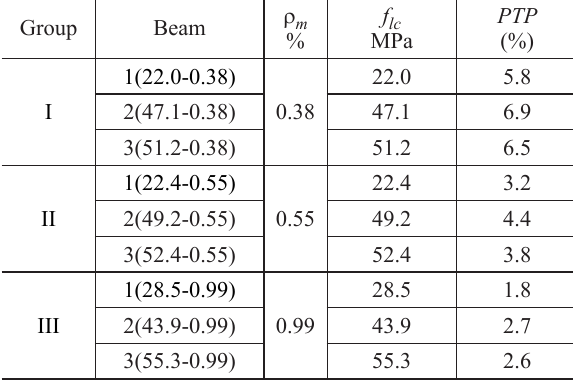
Table 3. Beams groups with similar reinforcement ratio